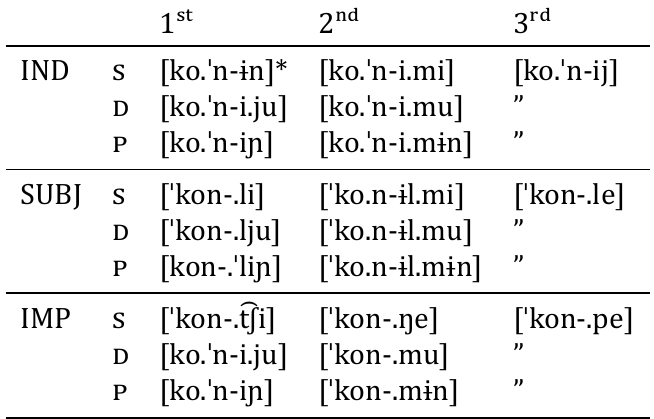
Table 14: Verbal paradigm for the consonant-(cid:976)inal root [kon-] ‘enter’, after Lenz 1895- 1897 and Augusta 1903. * = but also: [ku.ˈʈ͡ʂa.n-ɨn]